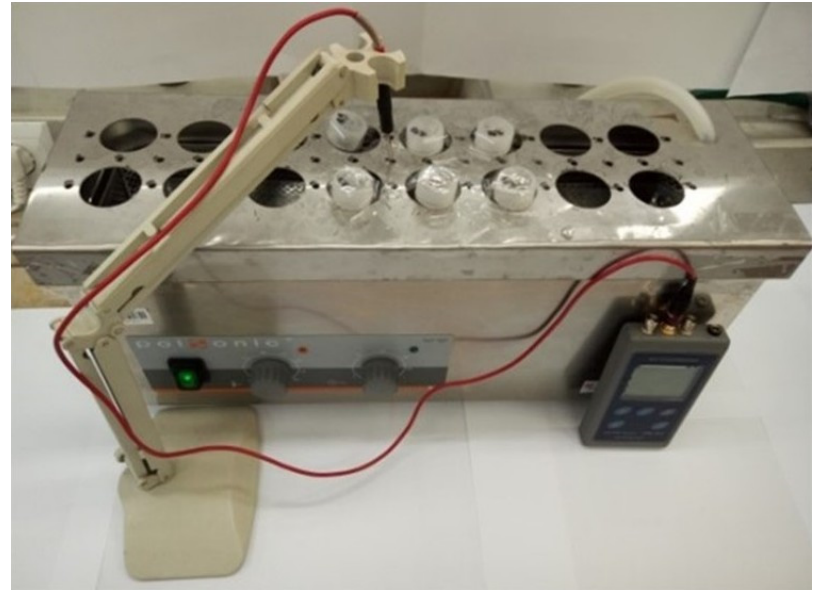
Figure 2. Laboratory-scale setup for the ultrasound treatment, equipped with temperature and time